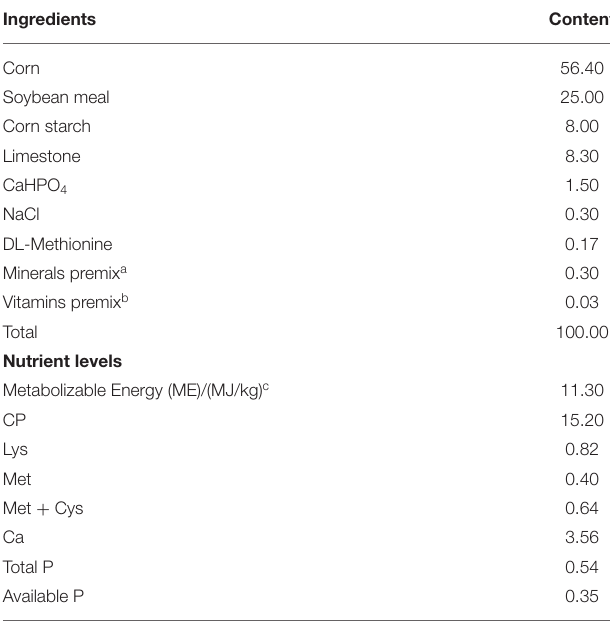
TABLE 1 | Ingredient and nutrient composition of gestation diets